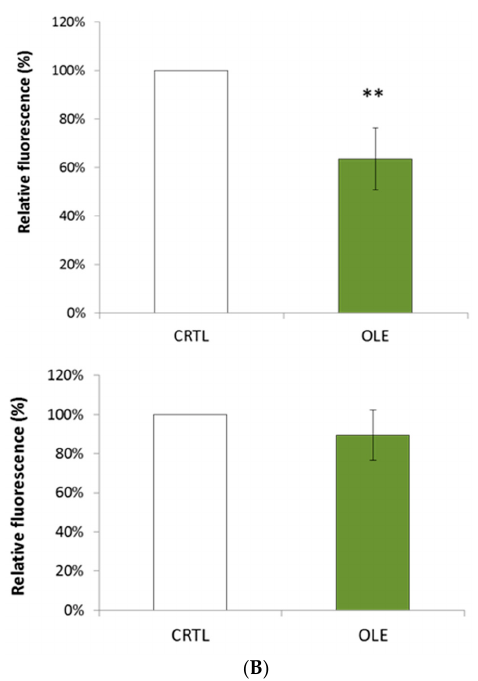
Figure 6. OLE decreases the number of acidic vesicles (red) but not lysosomes (green). ( A ) Representative microphotographs show that a 3 h treatment with 10 − 12 M OLE increases the number of acidic vesicles in neuronal PC12 cells as revealed by acridine orange staining (red) compared to CTRL. Conversely, immunofluorescence labeling of lysosome-associated membrane protein 2-a LAMP2 (green), a lysosome-specific marker, suggests no effect on the number of lysosomal vesicles. Scale bar = 10 µm; ( B ) Histogram represents semi-quantitative measures of acridine orange (red) and LAMP2 (green) fluorescence. Data are expressed as means ± SEM. n = 3. ** p < 0.01.